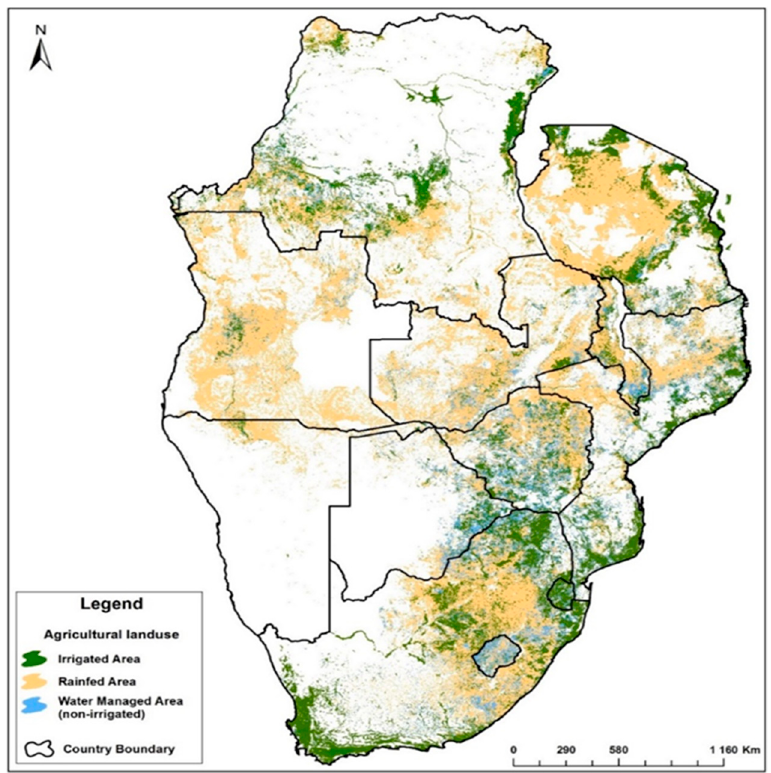
Figure 1. Cultivated landuse by agricultural system in Southern Africa.